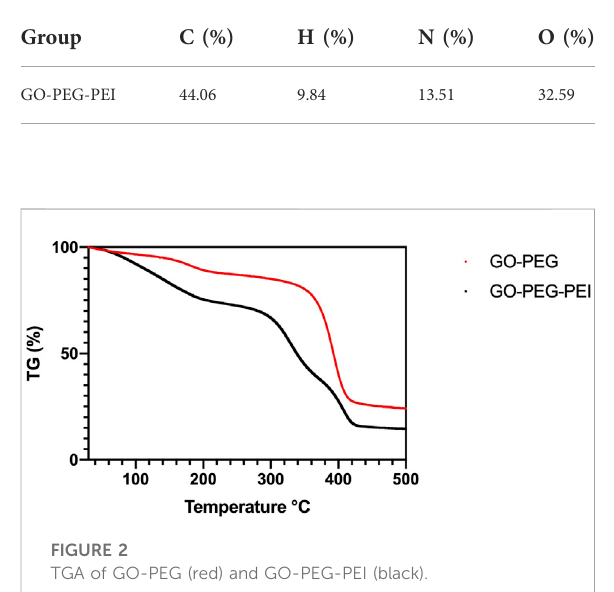
TABLE 2 Elemental analysis of GO-PEG-PEI.